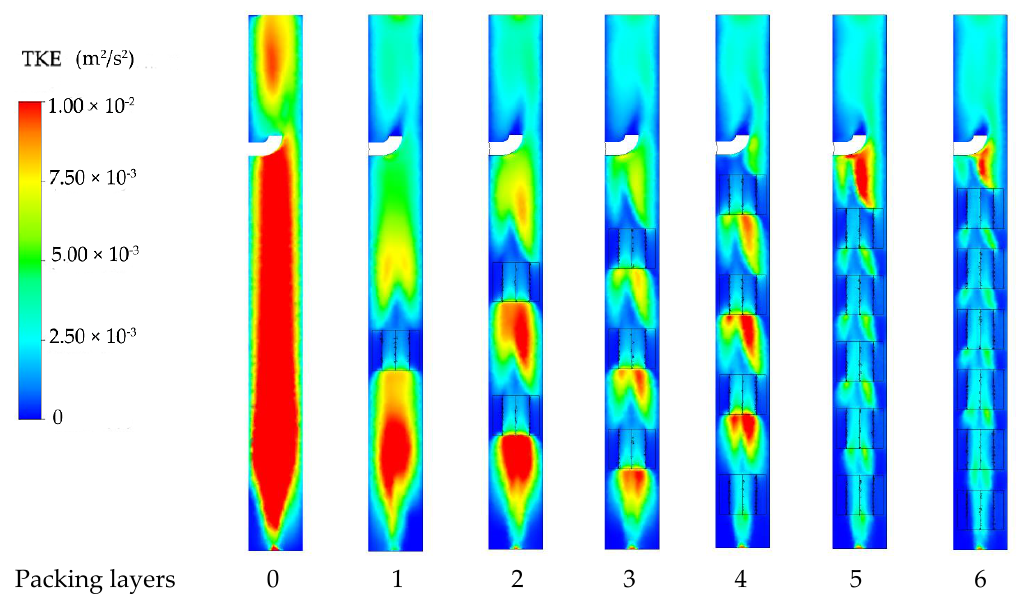
Figure 6. Influence of packing layers on turbulence kinetic energy characteristics in column.